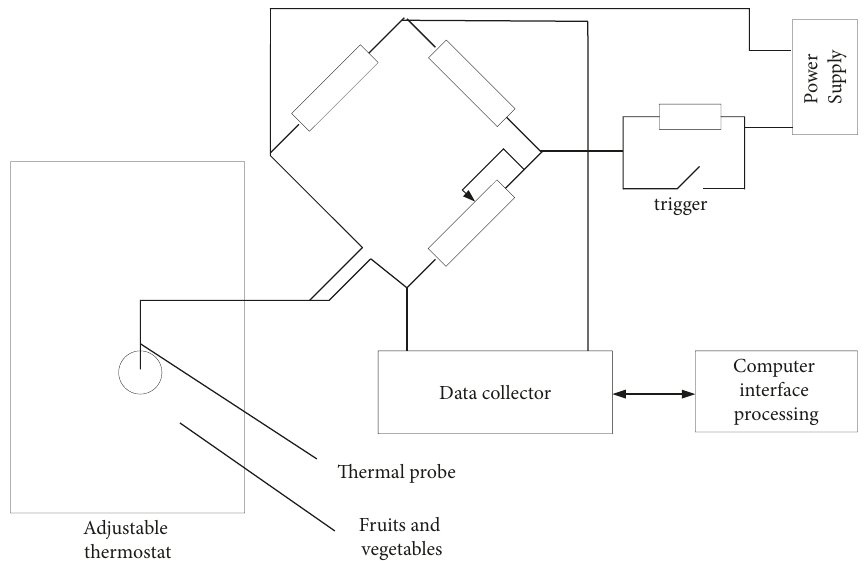
Figure 4: Test system